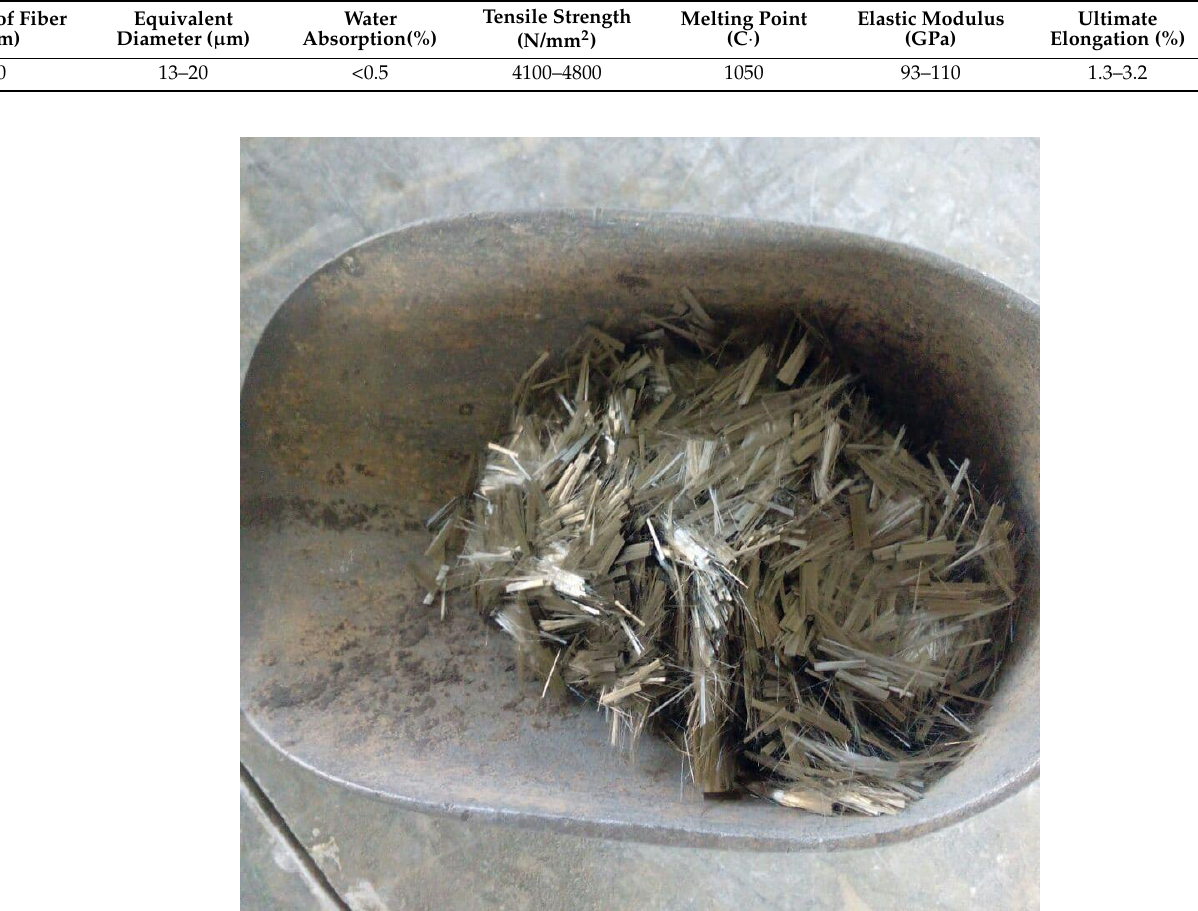
Figure 1. The basalt fibers (BFs) used in the production of the ECC mixture.